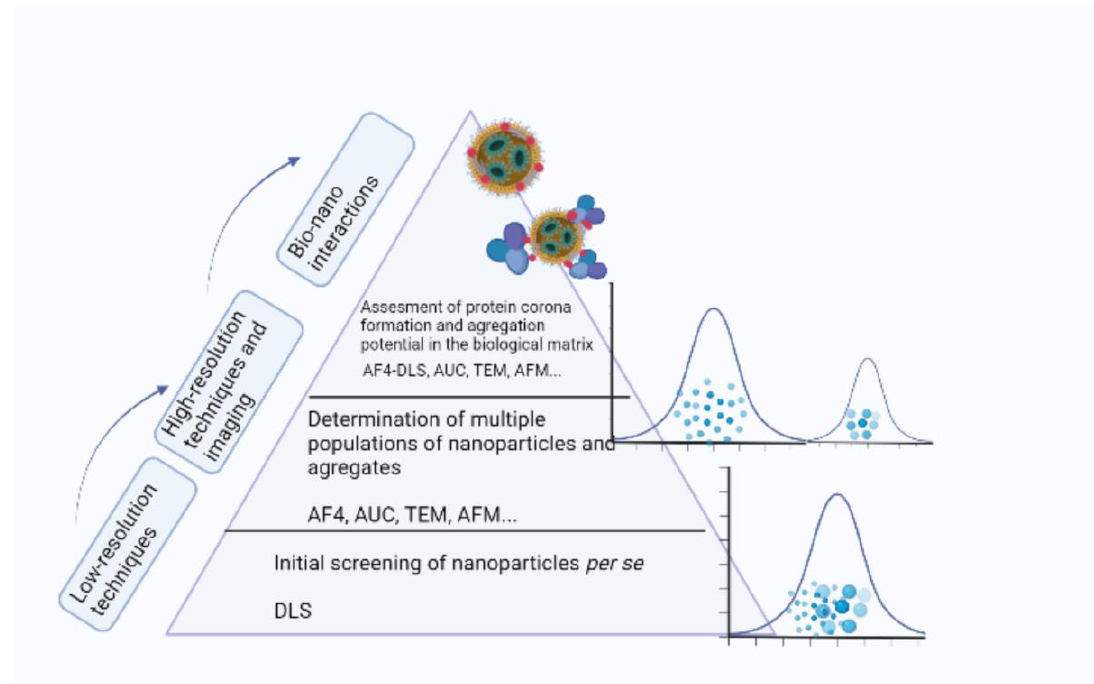
Figure 2. Necessary steps in the size characterization of nanoparticles (from bottom up): testing general sample properties applying low-resolution techniques; resolving multiple size populations of nanoparticles, aggregates, and larger particles; investigation on nanoparticle-protein interactions. Created with BioRender.com (accessed on 31 December 2022).